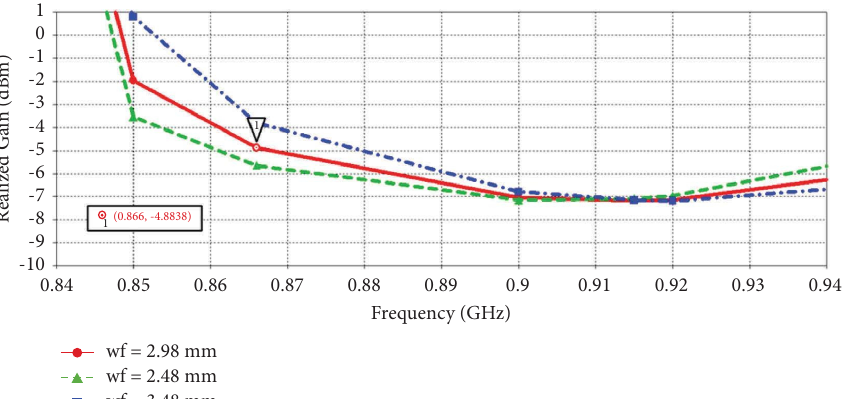
Figure 10: Gain performance of the tag with varying “ w